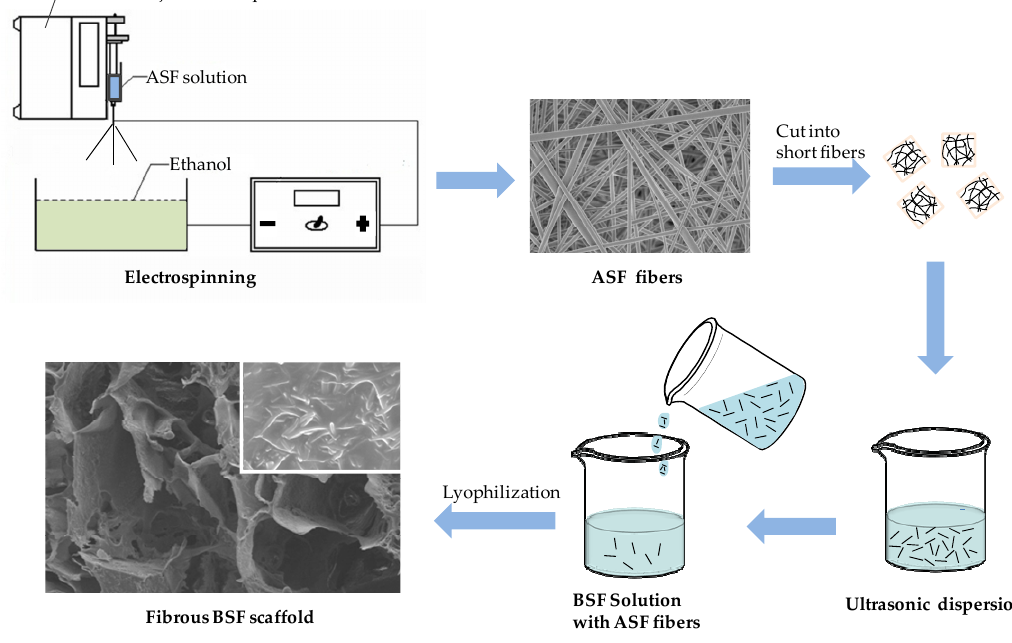
Figure 6. Schematic process of preparation for fibrousBSF scaffolds using freeze ‐ drying method.